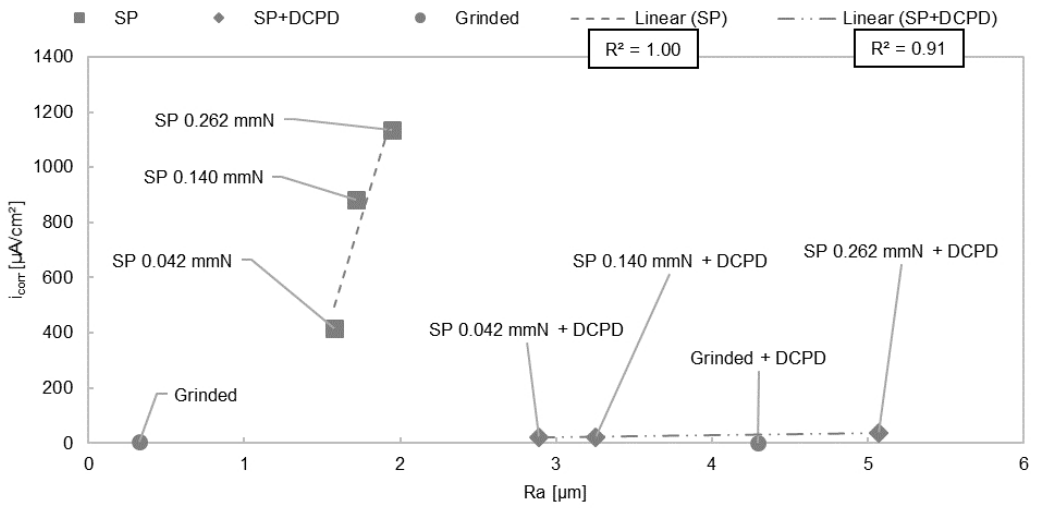
Figure 2. Diagram current density i corr against roughness Ra for ground, shot peened, and shot peened + DCPD coated samples. A non-linear R 2 relationship between Ra and i corr is shown by comparing all conditions (ground/SP/SP+DCPD) together. Linear R 2 is plotted for only shot peened or only shot peened and coated samples. A trend of linearity can be seen only for roughness values arising from same surface treatments. Ra and i corr values were obtained from [102].